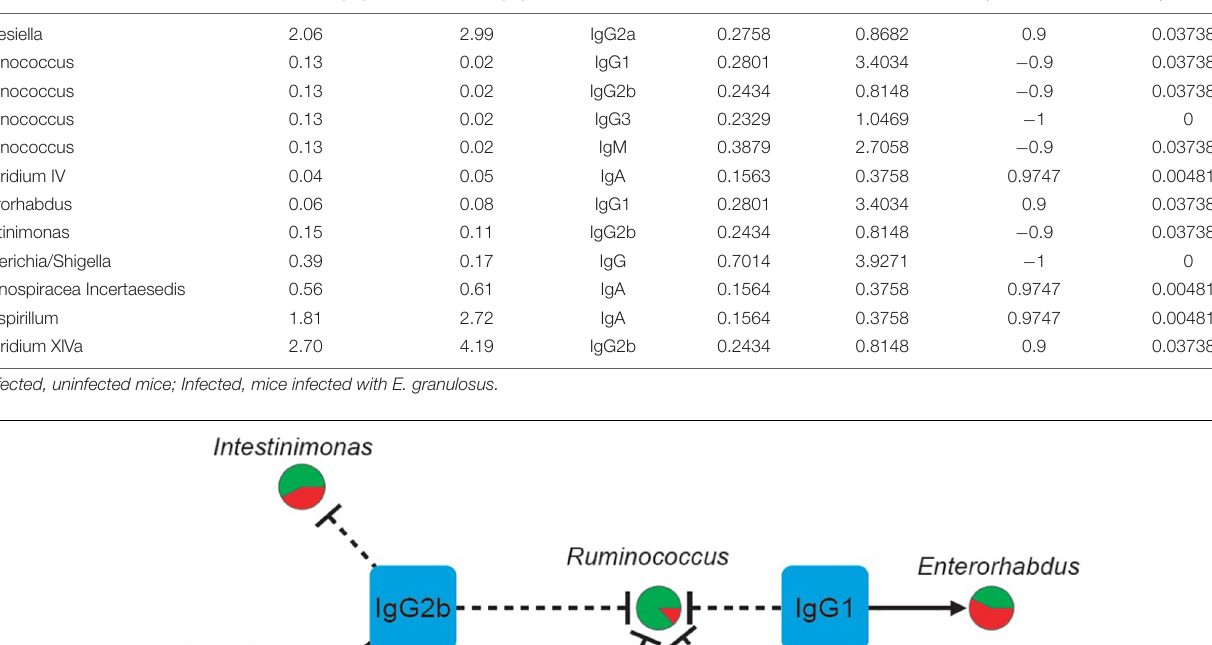
TABLE 7 | Genera of bacteria correlating highly with serum antibody isotypes in E. granulosus infected mice and uninfected mice. Genus